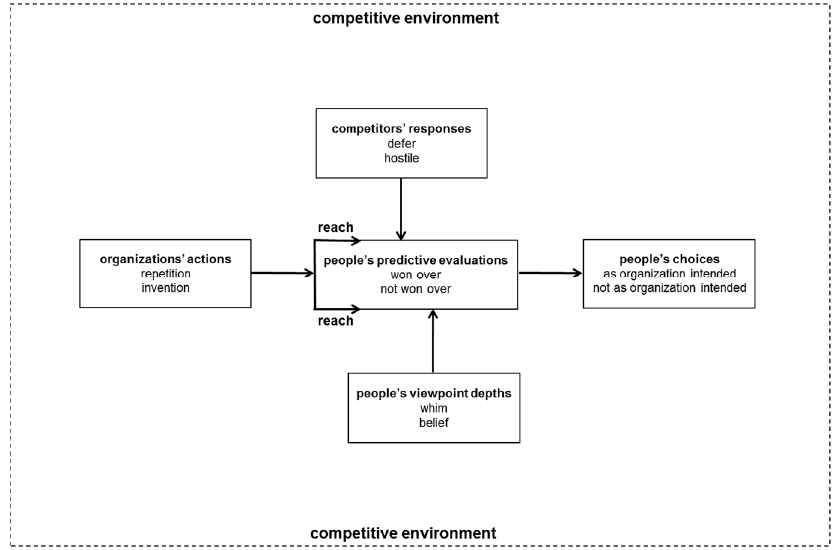
Figure 1. Framework. Figure 1.